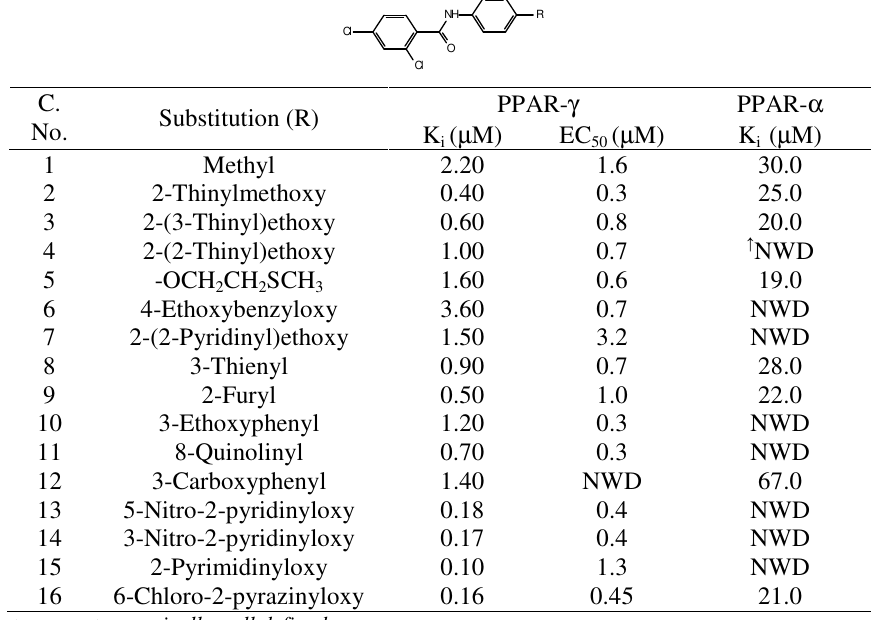
Table 1 Structure, in-vitro binding affinity in µ M (K (EC ) of 5-substituted-2- benzoylaminobenzoic acid analogs 50